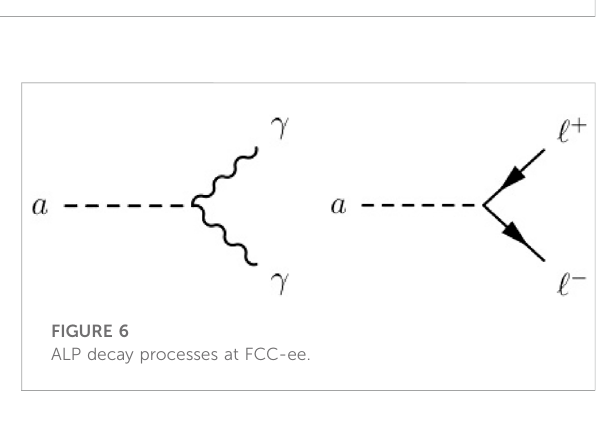
FIGURE 5 ALP production processes in electron-positron collisions.